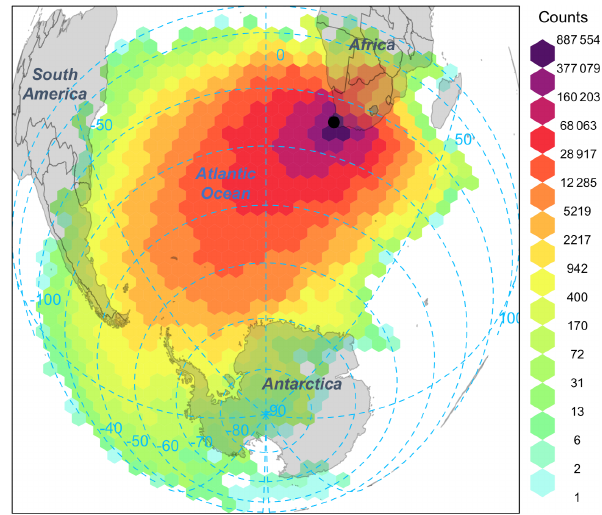
Figure 2. Origin of air masses influencing the Cape Point site (black dot). Gridded back-trajectory frequencies using an orthogonal map projection with hexagonal binning. The tiles represent the number of incidences. The 2007–2016 hourly back trajectories were com- puted using the HYSPLIT model (Stein et al., 2015), and the fig- ure was made using the R package openair (Carslaw and Ropkins, 2012).